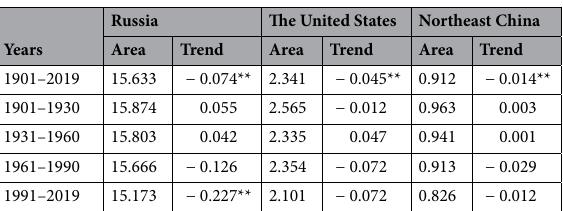
Table 4. The mean area of the cold regions (10 6 km 2 ) and change rate (10 6 km 2 /10 a) in Russia, the United States, and Northeast China from 1901 to 2019. “*” and “**”: P < 0.01 and 0.001, respectively.